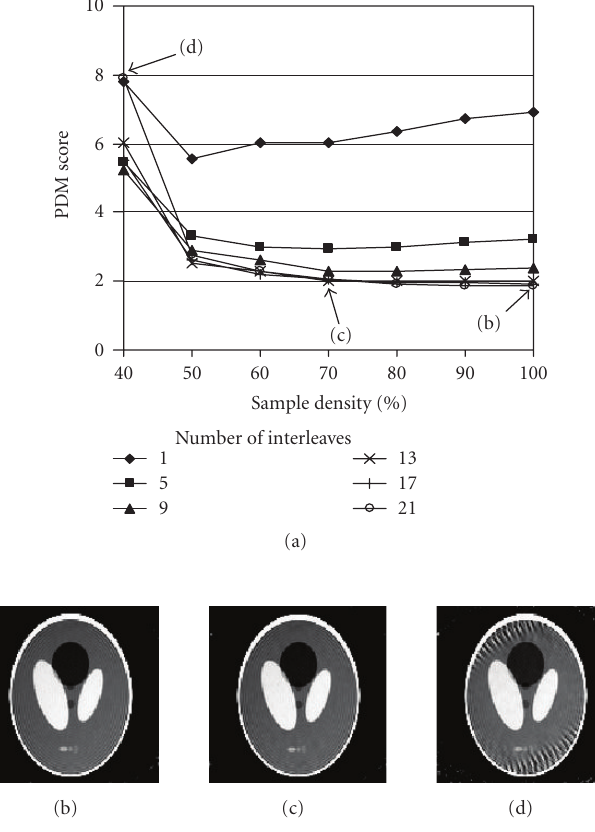
Figure 9: E ff ect of number of interleaves and sampling densities. In (a), PDM is plotted as a function of the sampling densities from 40% to 100% and 6 di ff erent numbers of interleaves. Other conditions (Voronoi method, conventional regridding, noise-free) were held constant. Images in (b), (c), and (d) correspond to 100% sample, 70% sample, and 40% sample and 21 interleaves, respectively, as